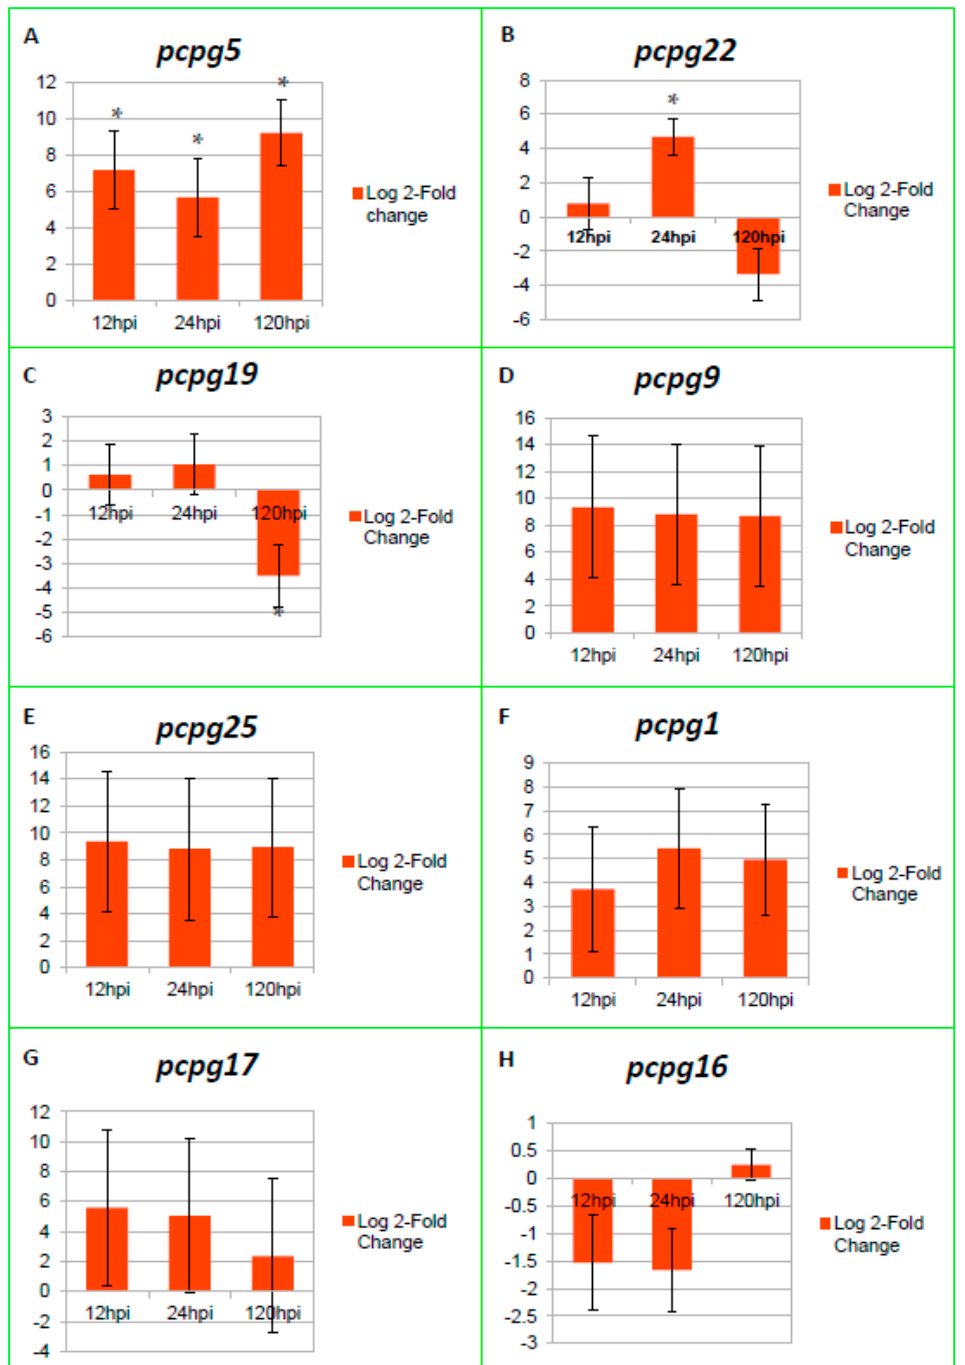
Figure 3. Time-course gene expression of eight PcPG genes expressed during colonization of a susceptible R0.12 avocado rootstock by Phytophthora cinnamomi . The Y-axis represents the log 2-Fold Change expression of ( A ) pcpg5 , ( B ) pcpg22 , ( C ) pcpg19 , ( D ) pcpg9 , ( E ) pcpg25, ( F ) pcpg1, ( G ) pcpg17, ( H ) pcpg16 , and the X-axis represents the different timepoints at which each gene is expressed during colonization. Expression profiles were generated from RNA-seq data obtained from infected susceptible R0.12 avocado roots harvested at 12 hpi, 24 hpi and 120 hpi. PG gene expression is indicated by a vertical bar, with error bars indicating standard error (SE). Statistical significance of PG expression was calculated using DESeq2, based on the read counts from the RNA seq data. Significant expression relative to mycelia at a p-adj-value of <0.05 is indicated by a single asterisk above/below each error bar. Log 2-Fold Change >1 represents up-regulated genes and log 2-Fold Change > − 1 represents down-regulated